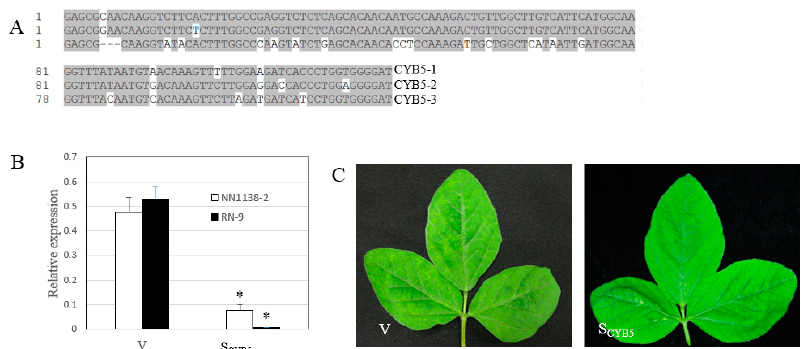
Figure 4. Silencing GmCYB5 in soybean. ( A ) Sequence of GmCYB5 isoforms used for silencing. Sequence alignment was carried out using ClustalW in the Megalign program of the DNASTAR package, with identical residues shaded in gray. ( B ) Relative mRNA levels of GmCYB5-1 isoform in soybean plants (cv. NN1138-2 and RN-9) infected with empty vector (V), or vector targeting GmCYB5-1 (S CYB5 ) as determined by qRT-PCR analysis. Error bars indicate SD ( n = 3). Asterisks denote significant difference in expression of the respective transcripts when compared to V plants, t -test, p < 0.001. Results are representative of two independent experiments. ( C ) Comparing symptoms of NN1138-2 plants with GmCYB5 mRNA expression (S CYB5 ) knocked down and that infected with the control bean pod mottle virus (BPMV) vector (V).